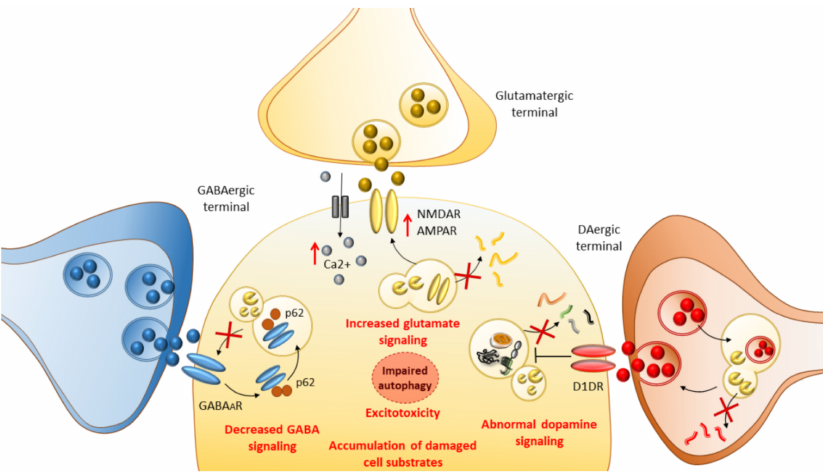
Figure 1. The role of autophagy in seizure-related molecular mechanisms. By operating at the level of gamma-aminobutyric acid (GABA), dopamine (DA) and glutamate systems autophagy are critically implicated in the molecular mechanisms underlying epileptogenesis and seizure-induced neuronal alterations. When a failure of autophagy occurs, elevated p62 hinders GABA A receptor surface presentation, leading to decreased GABA signaling. At the same time, a failure of autophagy occludes the degradation of glutamate receptors N-Methyl-D-Aspartate (NMDAR) and A-Amino-3-Hydroxy-5-Methylisoxazole-4-Propionic Acid (AMPAR), fostering abnormal glutamate signaling and Ca 2 + influx. This eventually leads to imbalanced excitatory–inhibitory neurotransmission underlying epileptogenesis. At the level of DA terminals, autophagy is seminal to blunt DA release by degrading DA-filled synaptic vesicles. Autophagy failure leads to abnormal DA release and abnormal stimulation of DA D1 receptors (D1DR), which in turn exacerbate autophagy suppression via mTOR hyperactivation. This eventually leads to the accumulation of damaged cell substrates which synergize with glutamate-related excitotoxicity to produce neuronal